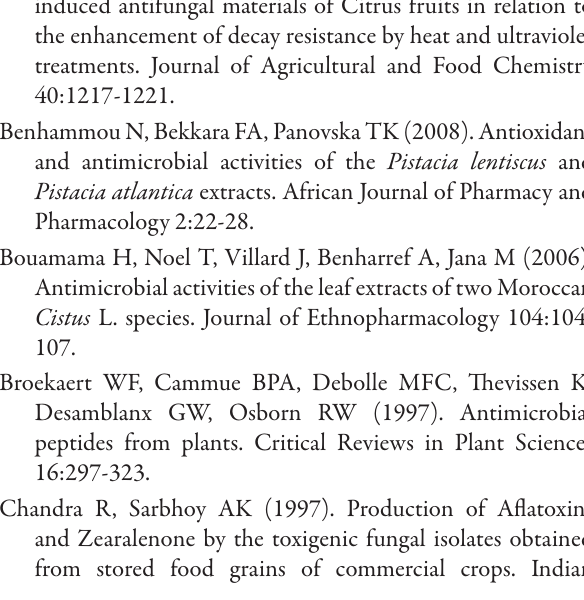
Tab. 2. Evaluation of in vitro antifungal activity against other fungi Ext. PM